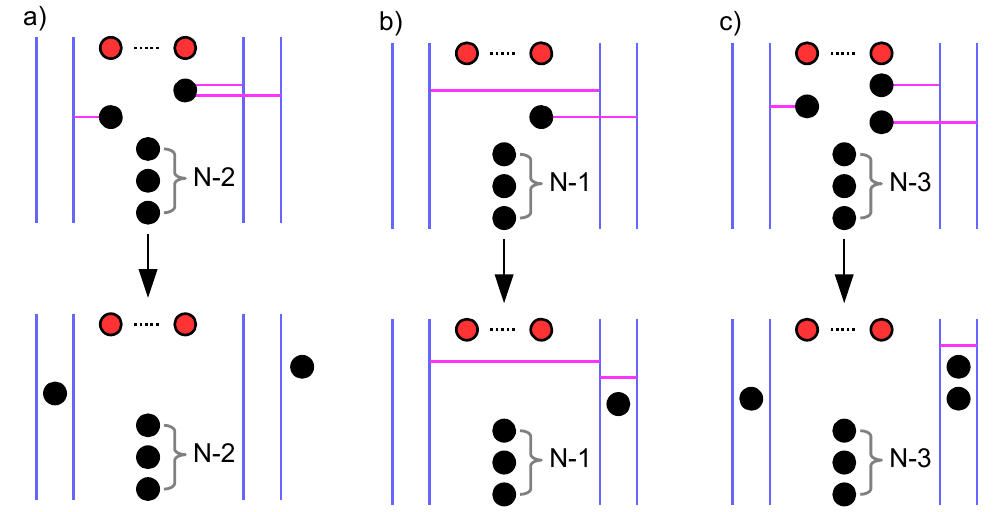
Figure 9 . This (cid:12)gure illustrates the brane setup for the con(cid:12)gurations contributing to the vacuum expectation value of two minimal positive operators and one minimal negative operator. The setup is depicted in the x 78 plane, where the NS5 (cid:0) /NS5 + branes are drawn to the left/right of the D5 branes in each diagram. a), b) and c) are an example of one of the diagrams contributing to each of the sums in the (cid:12)rst, second and third term on the r.h.s. of (4.49). The other terms contributing to these sums are given by permutations of the D3